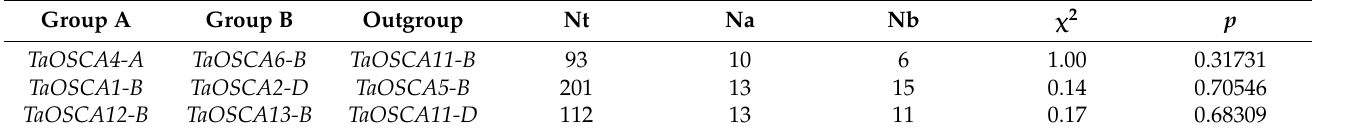
Table 2. Tajima’s relative rate tests of paralogous